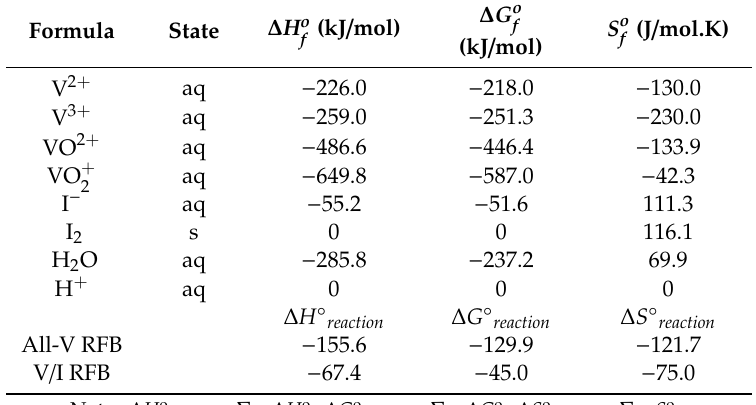
Figure 3. The temperature change ( Δ T ) of charge-discharge by monitoring of an infrared thermal imaging (ITI) of all-V RFB and V/I RFB as a function of the state of charge (SOC).